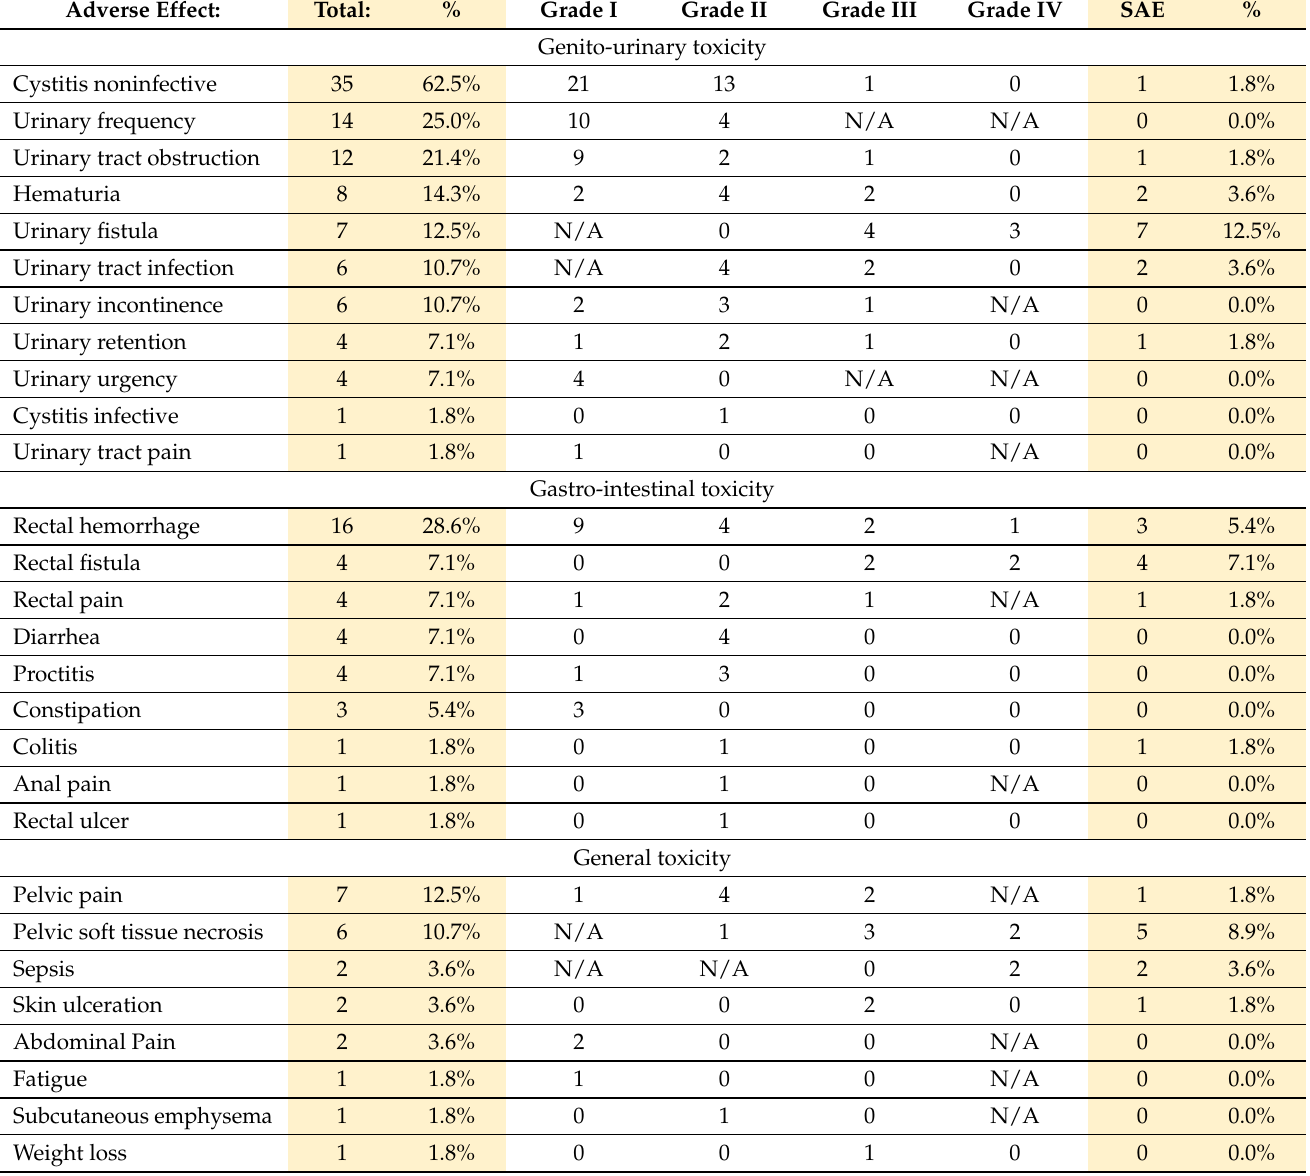
Table 2. Overall occurrence of adverse effects in 56 patients treated with hypofractionated salvage re-irradiation for local post-radiotherapy prostate cancer